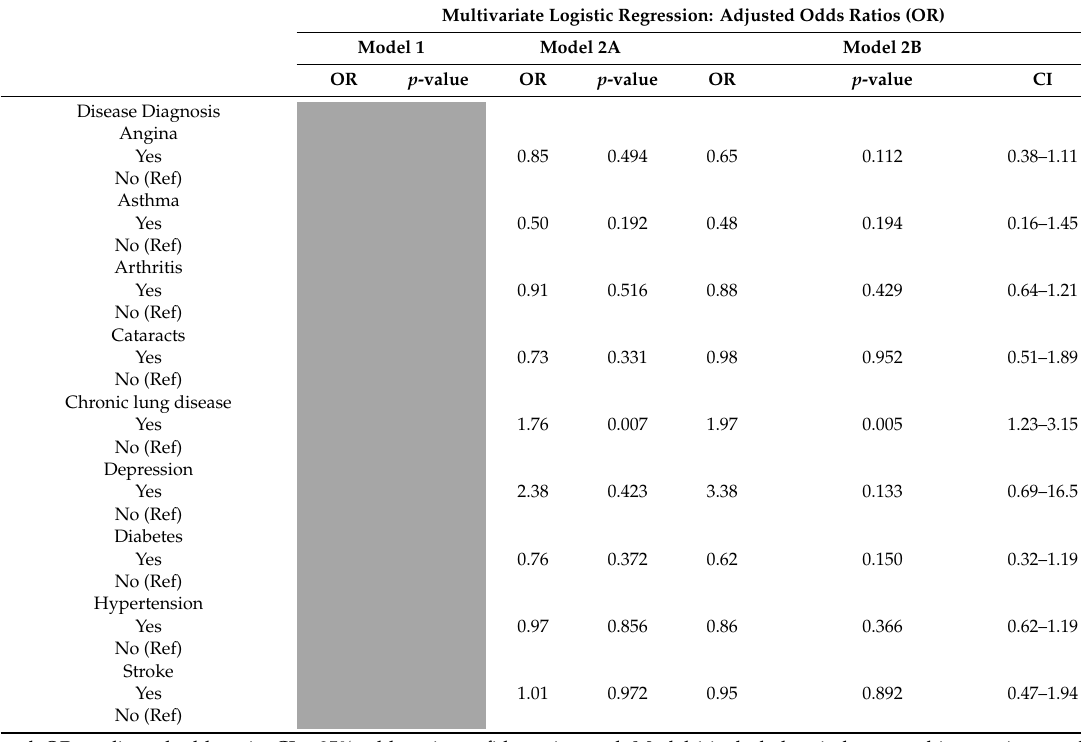
Table 3. Multivariate regression results on the utilization of TCM practitioners, WHO SAGE China (Wave 1). Multivariate Logistic Regression: Adjusted Odds Ratios